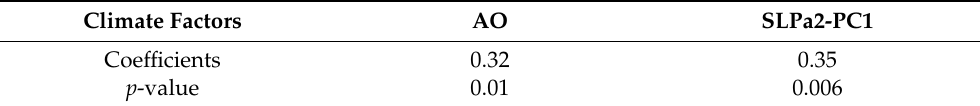
Figure 3. The scatter plots of AMFP versus JJA AO ( a ) and JJA SLPa2-PC1 ( b ) respectively. Table 2. Spearman correlation coefficients between climatic factors and AMFP.